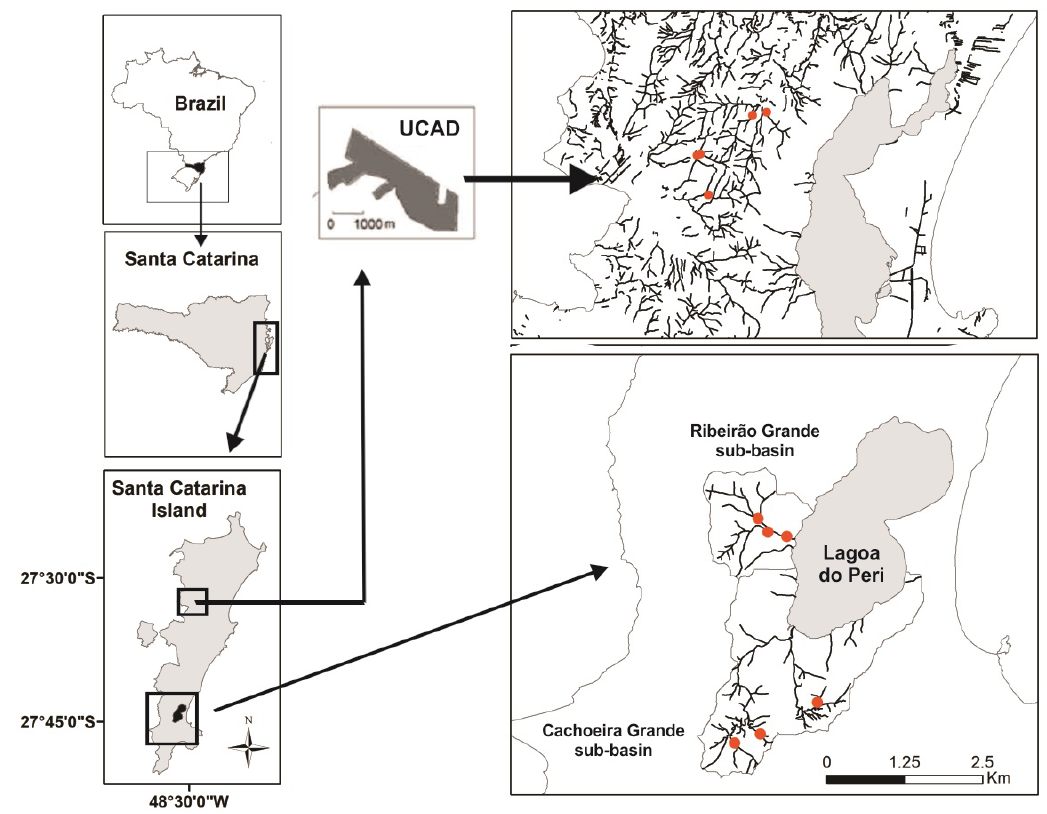
Figure 1. Location of the studied streams (orange circles) in Santa Catarina Island, southern